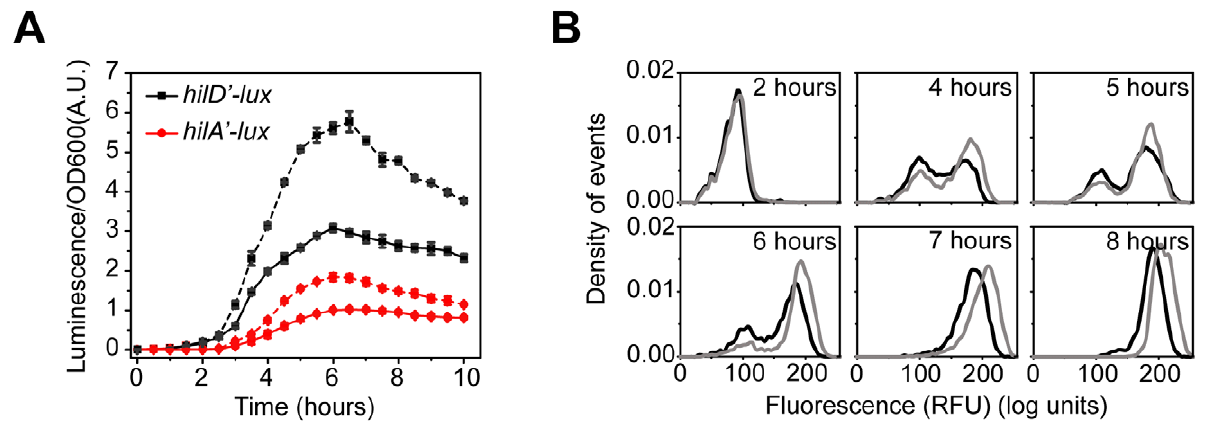
Figure 4. HilE dampens SPI1 gene expression. (A) Comparison of time-course dynamics for P hilD (pSS074, black) and P hilA (pSS077, red) promoter activities in wild type (solid lines) and a D hilE mutant (CR361, dashed lines) as determined using luciferase transcriptional reporters. (B) Comparison of P hilA (pSS055) promoter activities in wild type (black) and a D hilE mutant (CR361, grey) as determined using GFP transcriptional reporters and flow cytometry. Similar results are also observed with the P hilD promoter, though the phenotypic effect is much larger ( Figure S4 ). Experiments were performed as described in Figure 1 .